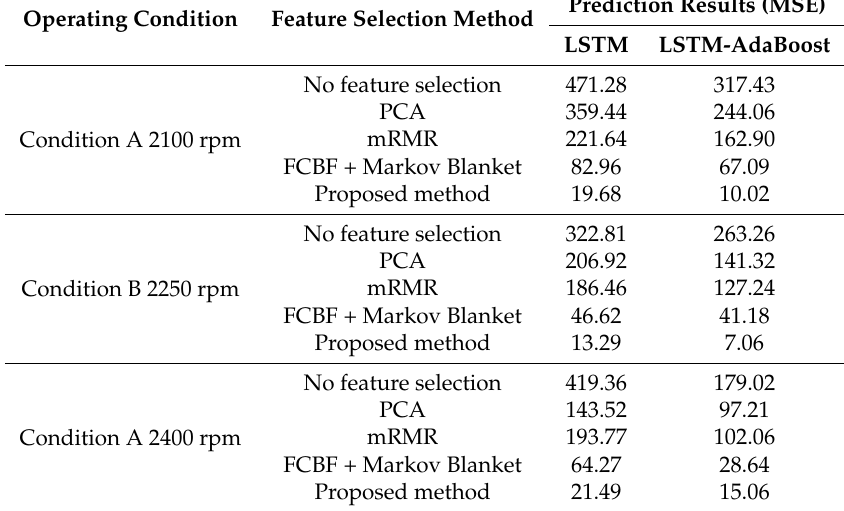
Table 3. Comparison of prediction accuracy of LSTM and LSTM-AdaBoost at motor speeds of 2100, 2250, and 2400 rpm using different feature selection